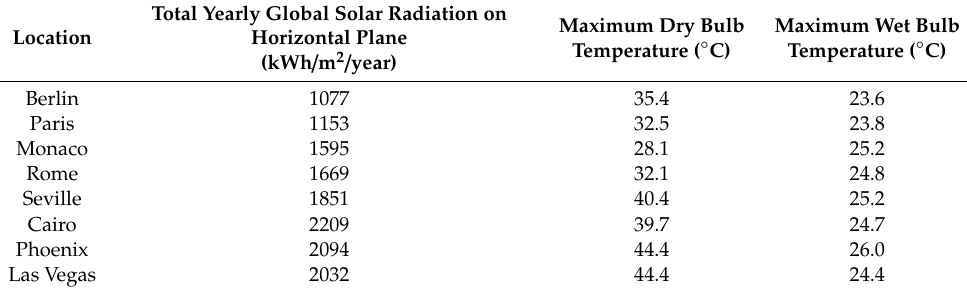
Table 3. TMY based data characteristics for each location.